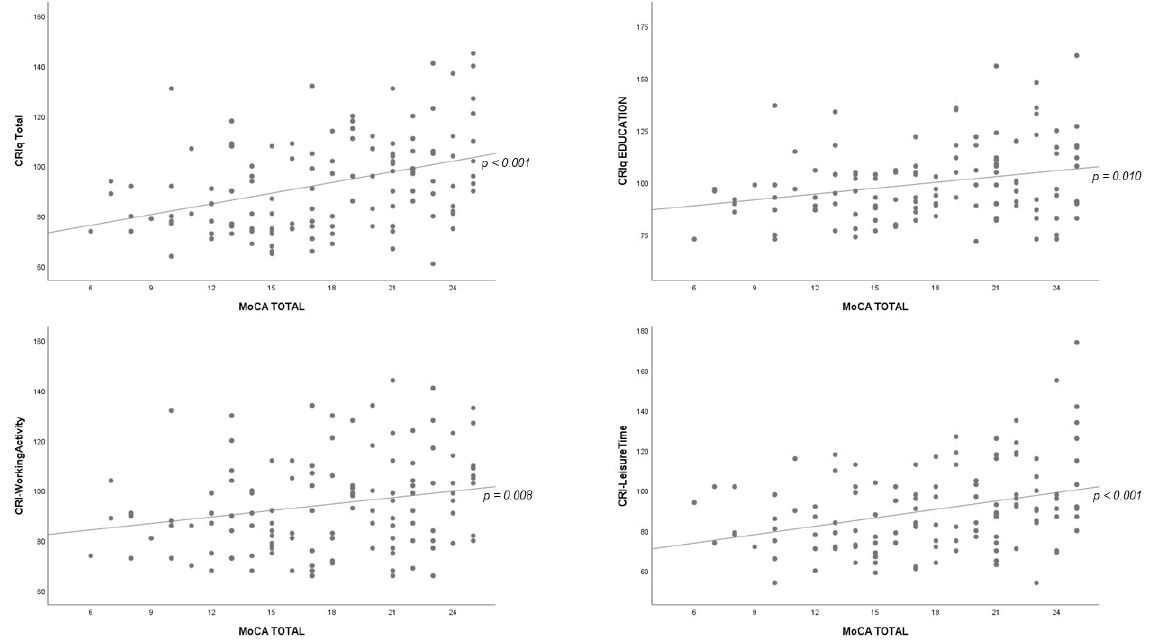
Figure 2. Scatter Plot for correlation analyses between CRIq score (Total and sub-domains) and MoCA score. Confounding factors that could distort the associations detected between the variables of interest were taken into consideration by bivariate correlation analysis. In particular, sex, age and depression were controlled for, the correlations previously detected remaining mostly statistically significant and positive. Thus, correlations between MoCA Score and total CRIq Total score (r = 0.319, p < 0.001), as well as in the sub-domine CRI-Education (r = 0.254, p < 0.005) and CRI-LeisureTime (r = 0.298, p < 0.001) remained statistically significant, but not for CRI-WorkingActivity (r = 0.126, p = 0.165) (Table 5). Table 5. Semi-partial correlation between CRIq and MoCA score adjusting for sex, age and depres- sion. CRIq 2